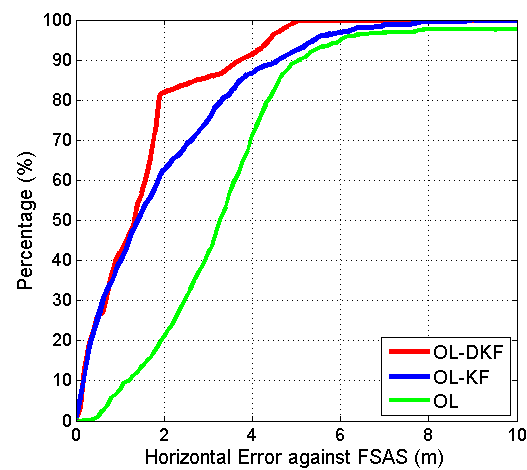
Figure 24. Position error probability of roads blocked by a light railway test.